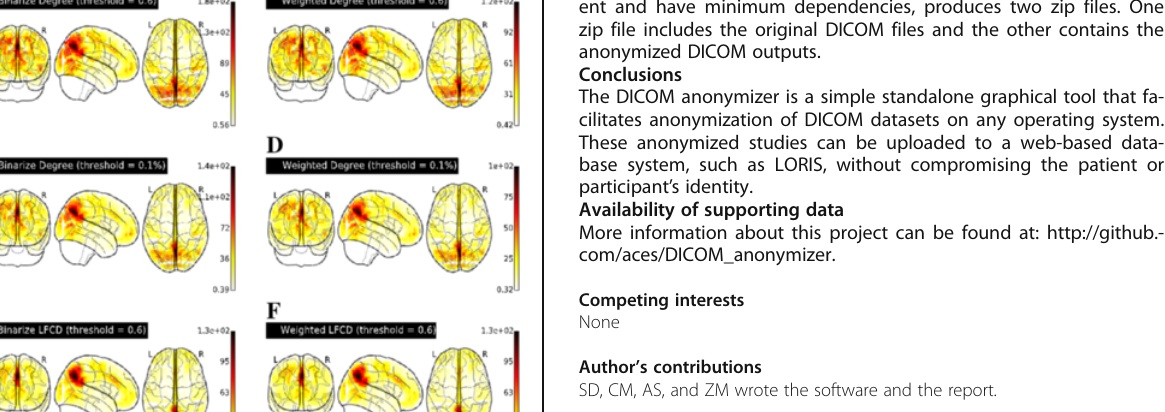
Fig. 3 (abstract A4). Whole brain maps of binarized and weighted degree centrality calculated with a correlation threshold of 0.6 ( a - b ) and sparsity threshold of 0.1 % ( c - d ) and binarized and weighted lFCD calculated with a correlation threshold of 0.6 ( e - f ) averaged across maps calculated the first resting state scan of the first scanning session for all 36 participants ’ data from the IBATRT